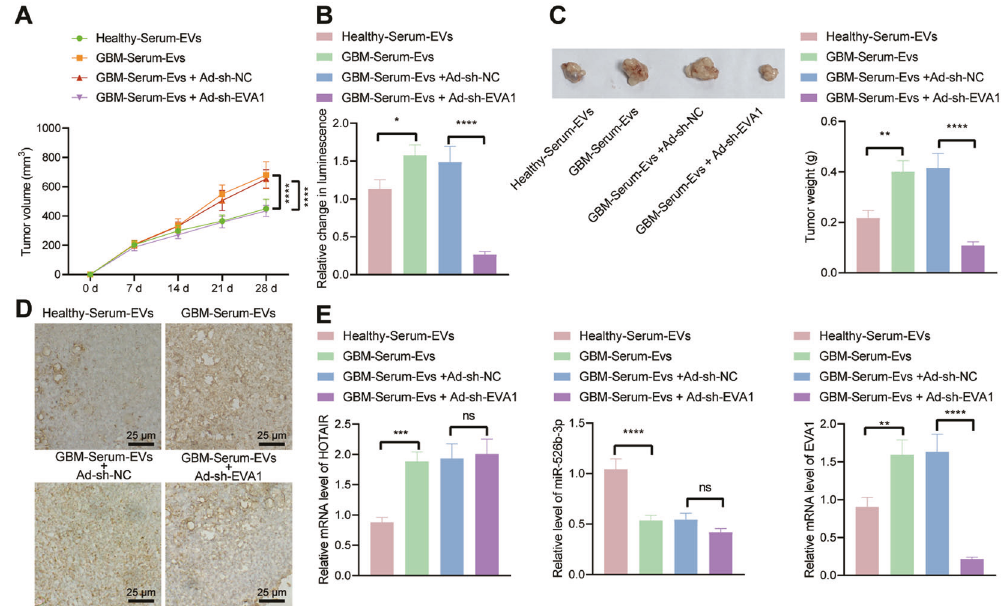
Fig. 6 HOTAIR-loaded in serum-EVs increases tumor growth and TMZ resistance in vivo via the miR-526b-3p/EVA1 axis. A Tumor volume of mice injected with U251 cells co-cultured with GBM-serum-EVs or combined with Ad-sh-EVA1. B In vivo luminescence changes of mice injected with U251-LUC cells co-cultured with GBM-serum-EVs or combined with Ad-sh-EVA1. C Representative images showing xenografts and tumor weight analysis of mice injected with U251 cells co-cultured with GBM-serum-EVs or combined with Ad-sh-EVA1. D Immunohistochemistry analysis of Ki67 protein in tumor tissues of mice injected with U251 cells co-cultured with GBM-serum-EVs or combined with Ad-sh-EVA1. E RT-qPCR detection of HOTAIR, miR-526b-3p, and EVA1 expression in tumor tissues of mice injected with U251 cells co-cultured with GBM-serum-EVs or combined with Ad-sh-EVA1. * p < 0.05, ** p < 0.01, * ** p < 0.001 or **** p < 0.0001. ns indicates no signi fi cant difference between the two groups. Each experiment was repeated three times independently. n = 10 for mice following each